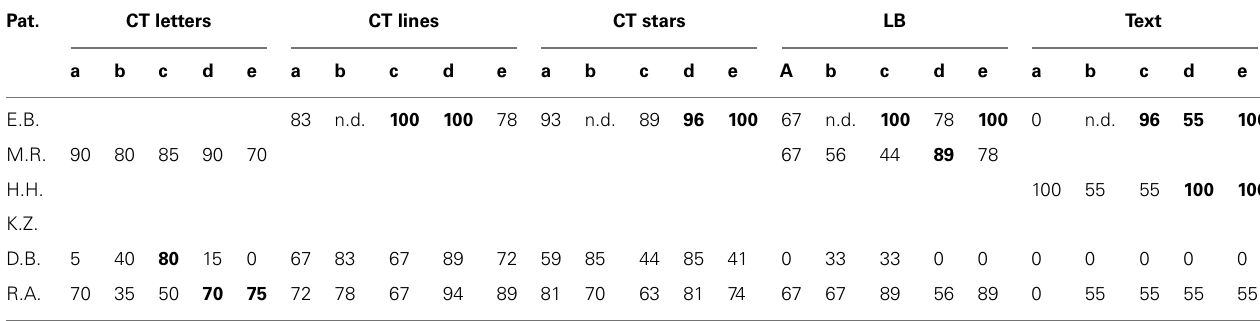
Table 2 | Results of paper and pencil tasks. Pat.